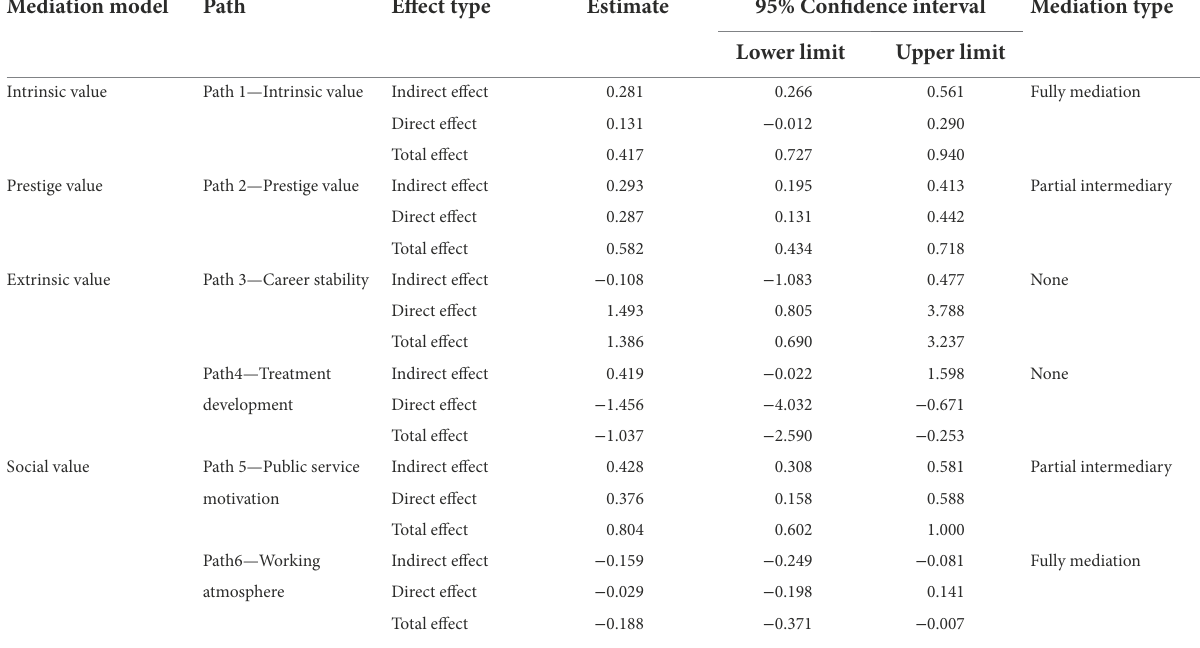
TABLE 12 Mediation effect